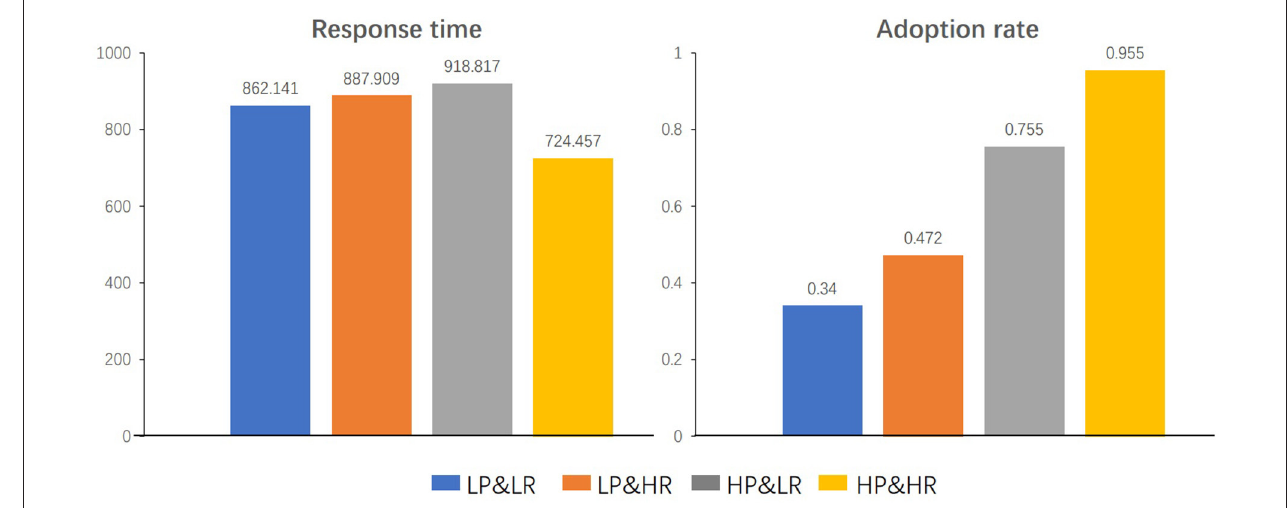
FIGURE 5 | Response time (right) and adoption rate (left) under different